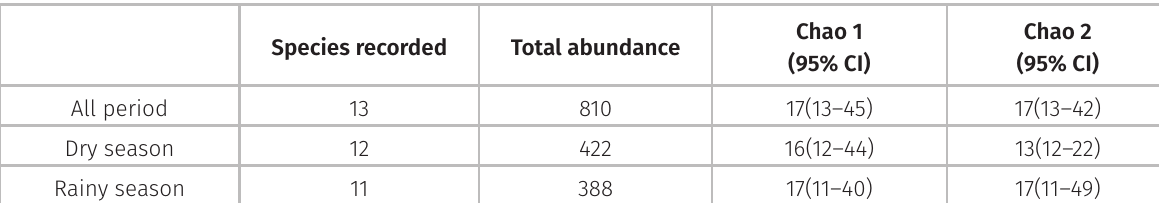
Table II. Lizard species richness, lizard abundance, and abundance (Chao 1)/incidence based (Chao 2) richness estimators across different